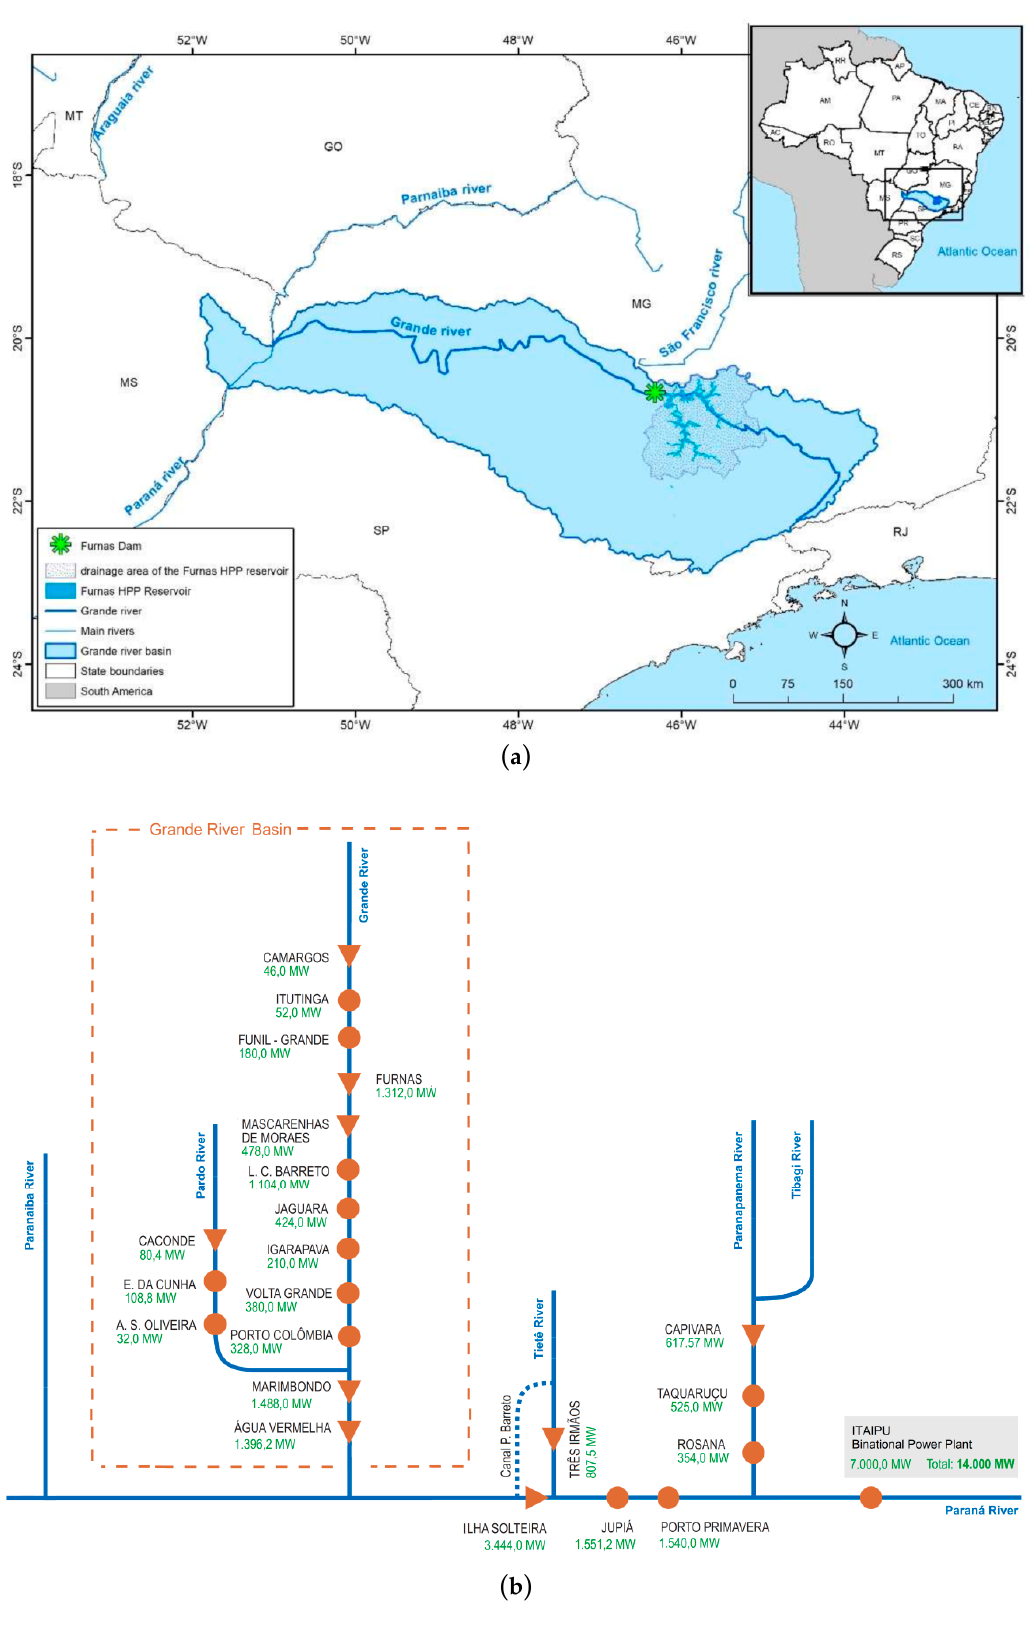
Figure 14. Location map of the Furnas Hydropower plant [66] ( a ), and Grande River cascade and partial Brazilian hydropower system ( b ).